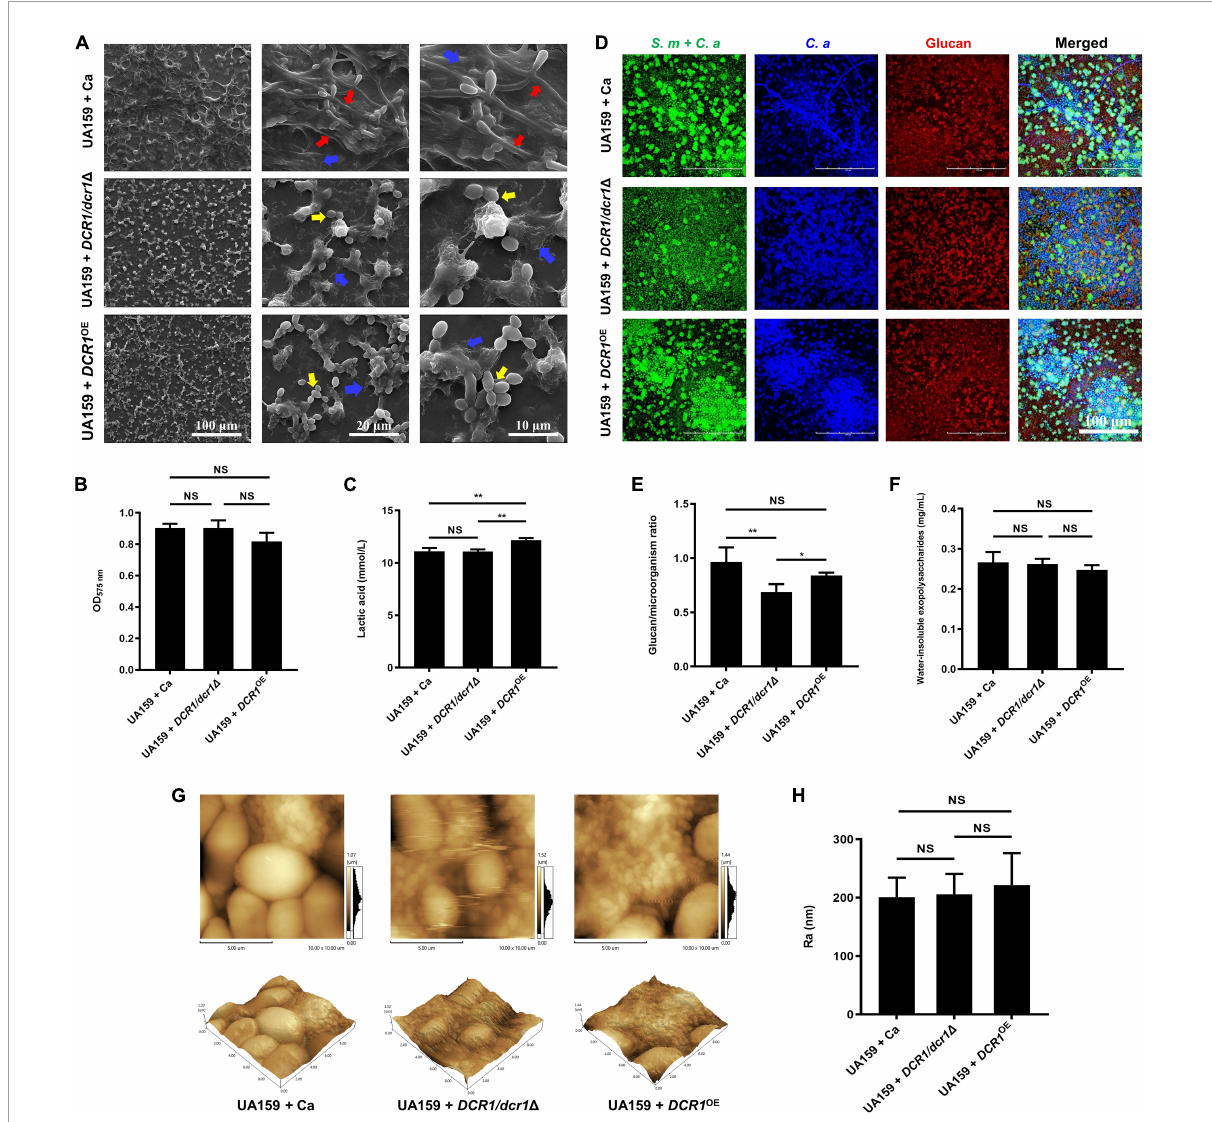
FIGURE1 The effects of DCR1 gene on formation and exopolysaccharide synthesis of cross-kingdom biofilm. (A) Biofilms architecture was observed by scanning electron microscopy (SEM). Blue arrows, S. mutans ; red arrows, C. albicans hyphae; yellow arrows, C. albicans yeast cells. Images were taken at 1,000 × (scale bar, 100 µ m), 5,000 × (scale bar, 20 µ m), and 10,000 × (scale bar, 10 µ m) magnifications, respectively. (B) Biofilms volume was quantified by CV microtiter assay. (C) Lactic acid generation was assessed by the Lactic Acid Assay Kit. (D,E) Exopolysaccharide production and distribution in biofilms were visualized by confocal laser scanning microscopy (CLSM), and the ratio of glucan to microbes was calculated using Imaris version 7.2.3. Green, total microbes (SYTO 9); blue, C. albicans (calcofluor white); red, glucan (Alexa Fluor 647). (F) Water-insoluble exopolysaccharides from samples were measured by the anthrone method. (G,H) Biofilm morphology was detected by AFM and the surface roughness average (Ra) of biofilms was evaluated. Experiments were performed in biological triplicate. * P < 0.05, ** P <